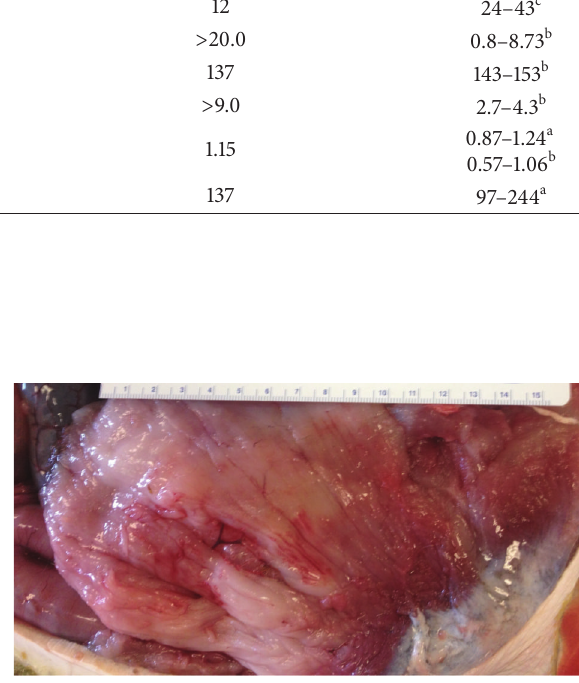
Figure 1: The left superficial and deep pectoral muscles of a green sea turtle ( Chelonia mydas ). Multifocal regions of pallor are